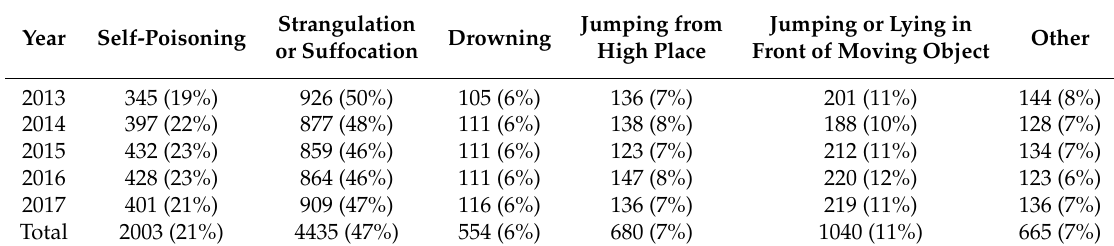
Table 10. Number of suicides among the general Dutch population separated out by method of suicide (percentage of total in year in